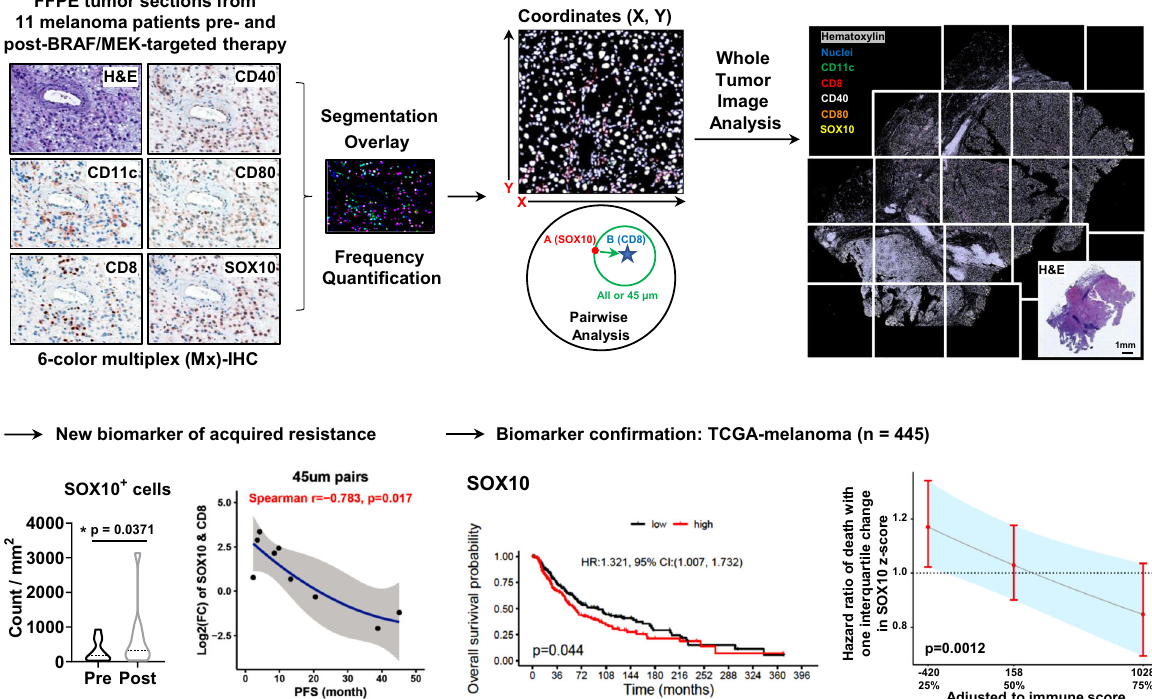
Fig. 1 Overall work fl ow of MxIHC and spatial analysis. The analysis started with bright fi eld MxIHC staining and whole-tumor image scanning. For each patient slide, image segmentation was performed to quantify the frequency of targeted cells and to obtain coordinates. The coordinate list from each slide was fed to pairwise analysis to calculate the relative intervals between targeted cells. The association between the survival and immune score signature or new biomarkers (SOX10 and MLANA), as well as adjusted HR plot based on the added value of a new marker into the immune score signature, were assessed in Skin Cutaneous Melanoma (TCGA, Firehose Legacy)